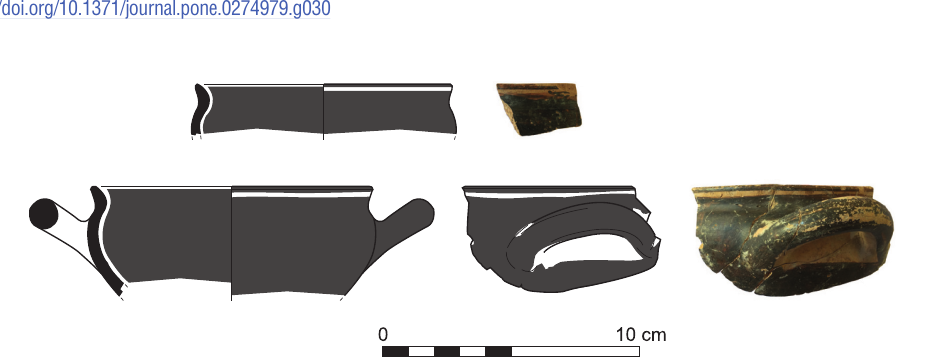
Fig 31. Fragments of Greek (NAA) monochrome skyphoi from Sidon phase I dating to Middle Geometric II / Subprotogeometric IIIB.